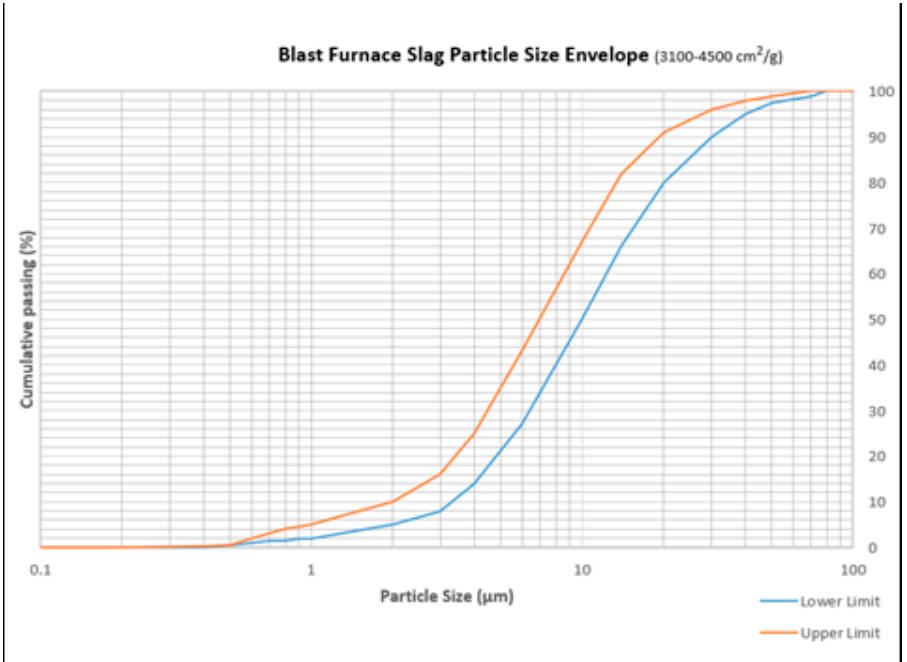
Figure 1. Blast furnace slag (BSF) cumulative particle size distribution (3100–4500 cm 2 /g).